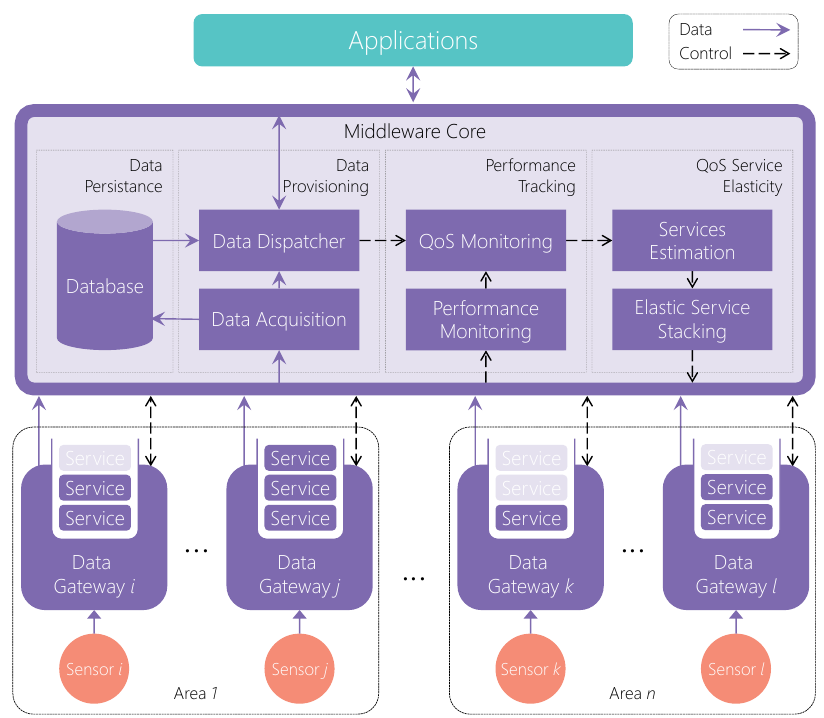
Figure 2. Middleware model and its components. The model comprises n hospital areas equipped with several sensors. A Data Gateway component extracts its data and sends them to the Core for each sensor. The Gateway instances have individual dynamic service stacks that contain QoS services employed to the sensor data. In turn, the Core is the main component responsible for providing data to applications, monitoring applications and Gateway instances’ performance, and orchestrating the QoS service